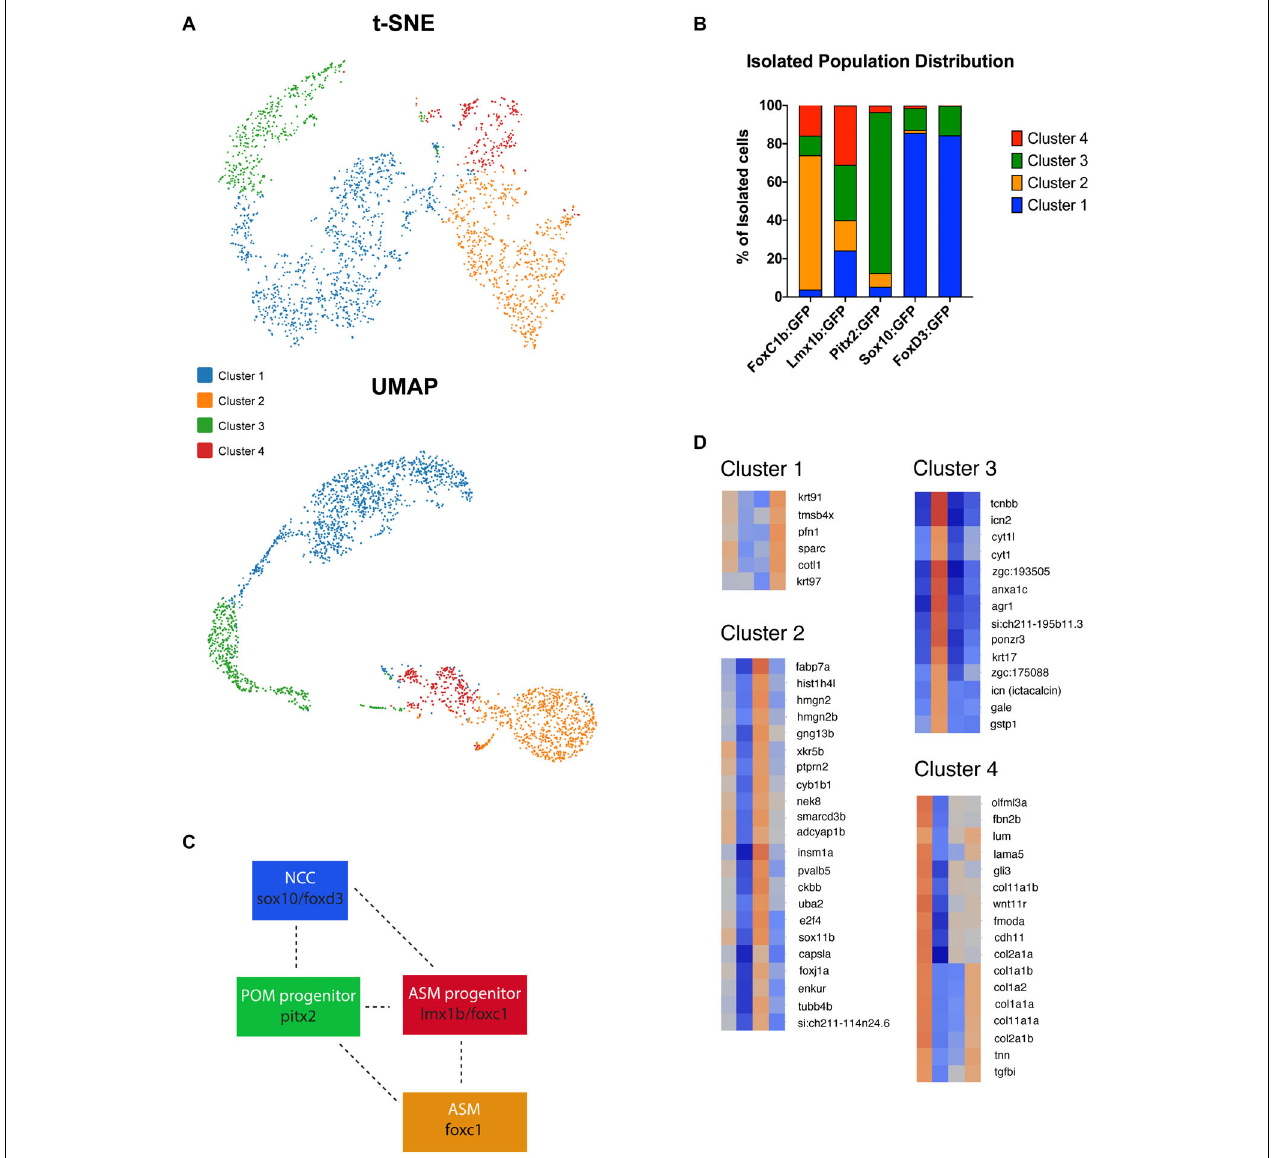
FIGURE 5 | Anterior segment mesenchyme single cell clustering analysis at 48 hpf. (A) K -means clustering of scRNA sequencing of isolated 48 hpf foxc1b :GFP, lmx1b :GFP, sox10: GFP, foxd3 :GFP, and pitx2 :GFP ASM cells in both tSNE and UMAP readouts. Both plots identified four general clusters. (B) Distribution of isolated ASM cells within each of the clusters generated by the Cell Ranger3.1 software. (C) Model of identified cluster interactions. Interaction and overlap is indicated by dashed lines. (D) Heat maps of cluster specific gene expression patterns.